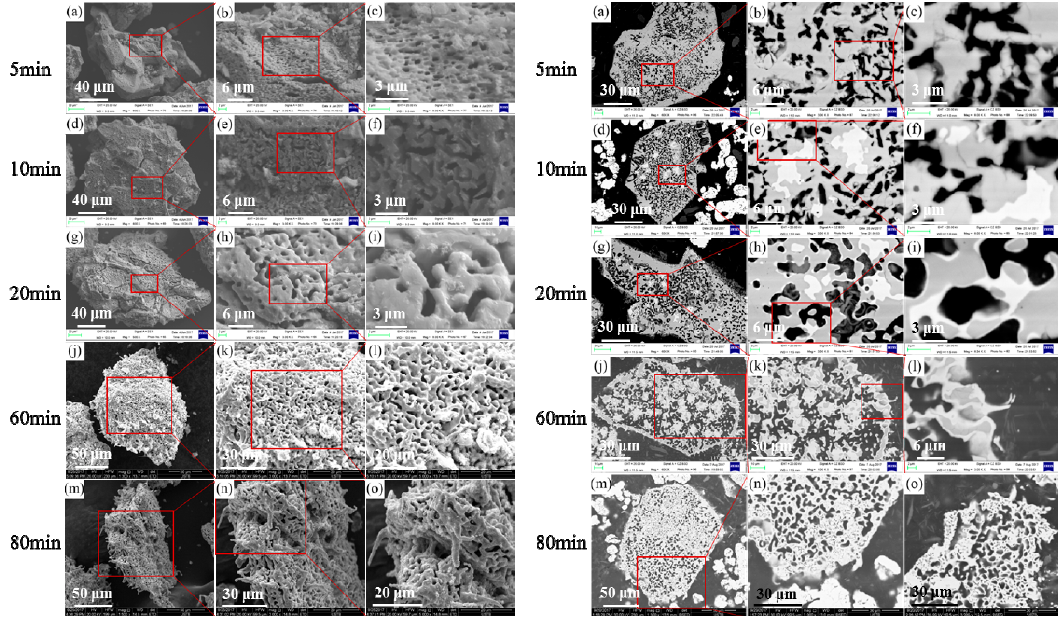
Figure 10. Microscopic observation of the particle surface morphology (left column) and the cross-section morphology (right column) of the iron ore particles after reduction at 1173 K in 95% CO + 5% CO 2 atmosphere.